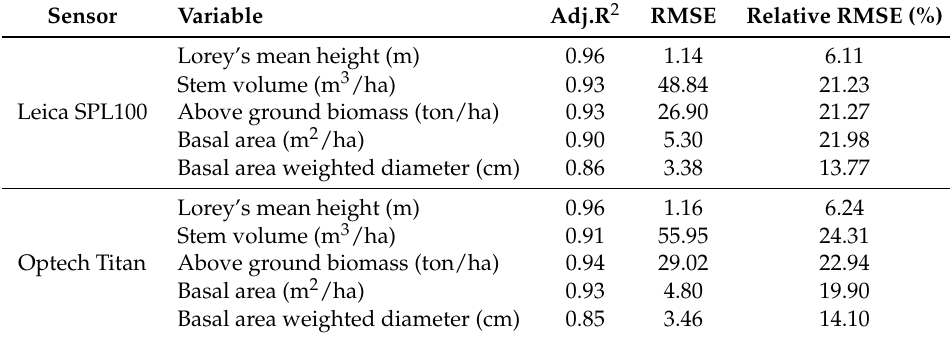
Table 4. The table presents estimation accuracy and coefficient of determination for the two lidar